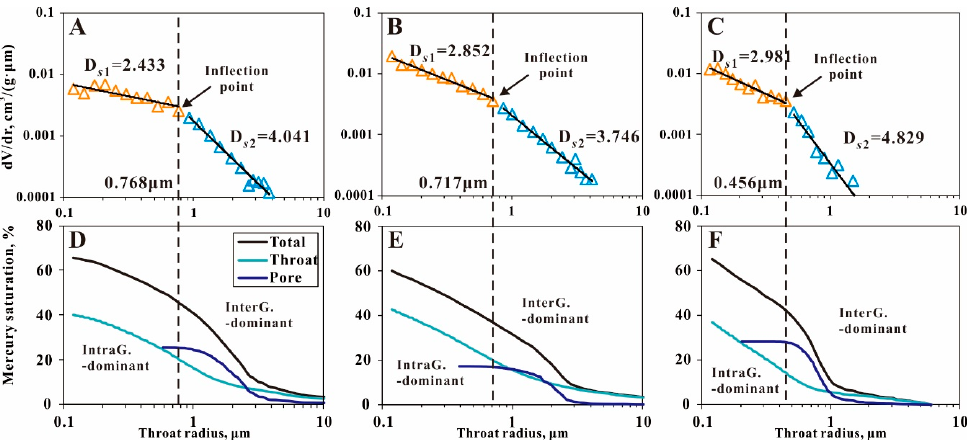
Figure 10. Surface fractal structure of throats ( A – C ) and mercury intrusion curves of total (pores + throats), pores and throats ( D – F ), derived from the RMIP experiment of three typical tight rock samples. ( A , D ): Sample #1, 0.93 mD; ( B , E ): sample #2, 2.35 mD; ( C , F ): sample #4, 0.26